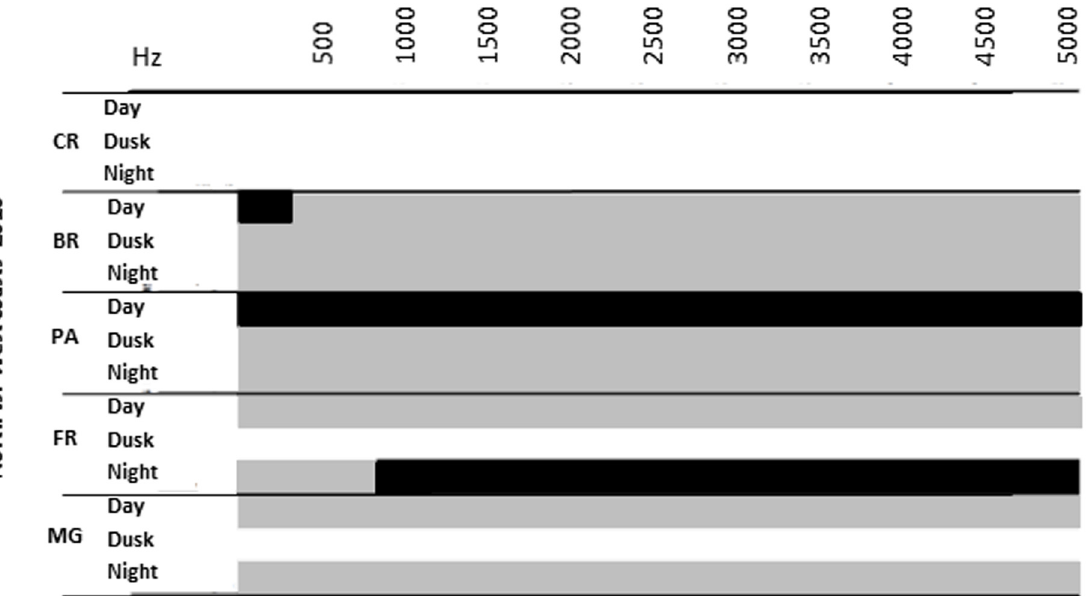
Fig 4. Comparison of sound intensities between the North and West Coasts in 2010. Results of sampled frequencies (Fast Fourier Transform FFT, 512 points Hamming window, 86.13 Hz resolution, in the 20 – 5000 Hz range). Black = P < 0.05. Grey = non-significant difference (Tukey ’ s multiple comparison post-hoc test). White = no data